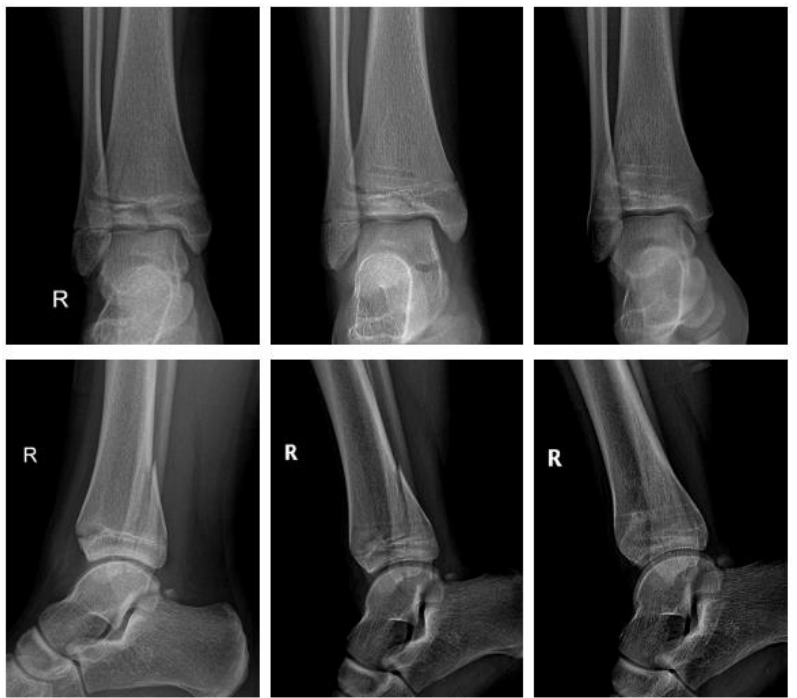
Figure 7. Triplane fracture with ActivaScrew TM : preop, 1 week postop, 6 months postop (left to right).